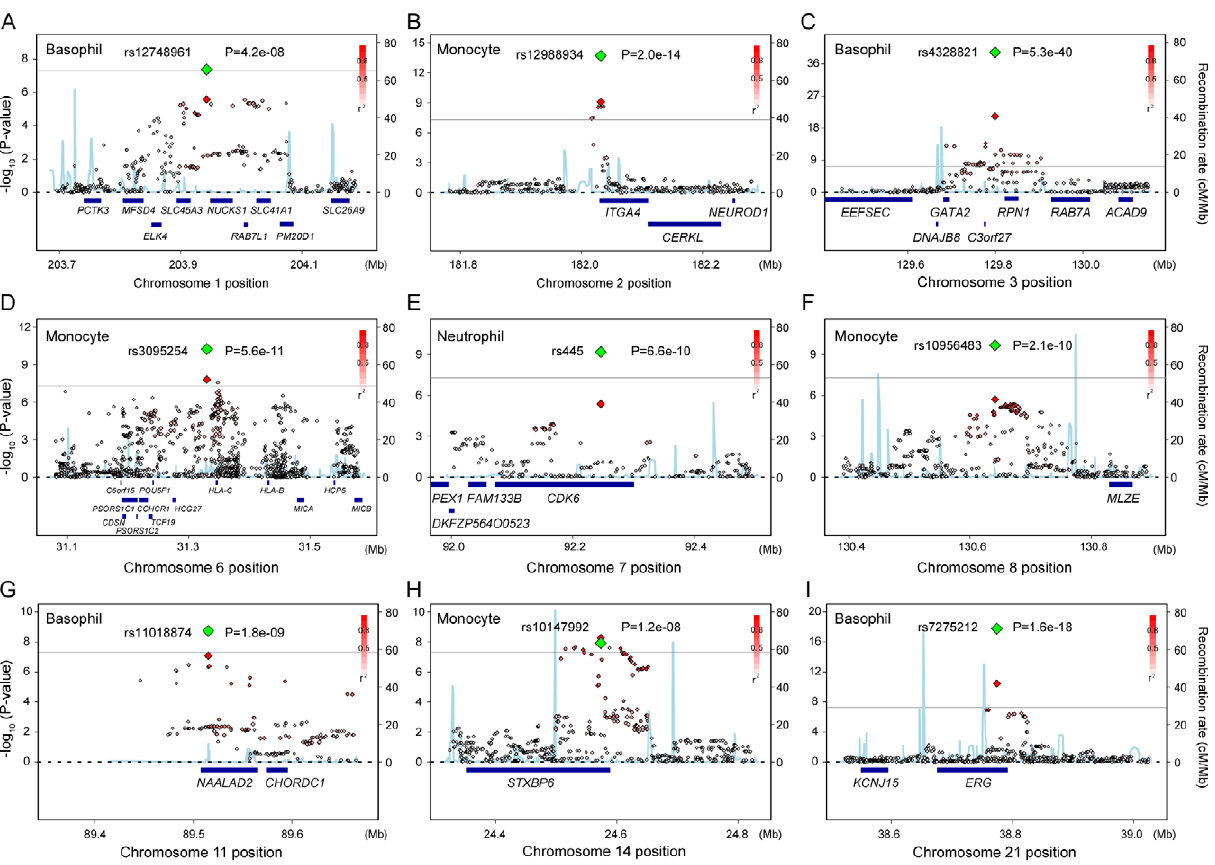
Figure 2. Regional plots of the novel genetic loci associated with the WBC subtypes. (A–I) Regional plots of the SNPs in the 9 novel loci identified in the GWAS for neutrophil, lymphocyte, monocyte, basophil, and eosinophil counts. Diamond-shaped dots represent -log 10 (P-values) of the SNPs. The green dot indicates the P-value of the most significantly associated SNP in each of the loci in the combined study, and the red dot indicates its P-value in the GWAS. The density of the red color in the small-sized dots represents the r 2 value with the most significantly associated SNP of the large-sized red dot. The blue line shows the recombination rates given by the HapMap database. The gray horizontal line represents the genome-wide significance threshold of P =5.0 6 10 2 8 . The lower part indicates the RefSeq genes in the locus. The plots were drawn using SNAP, version 2.1 [48].